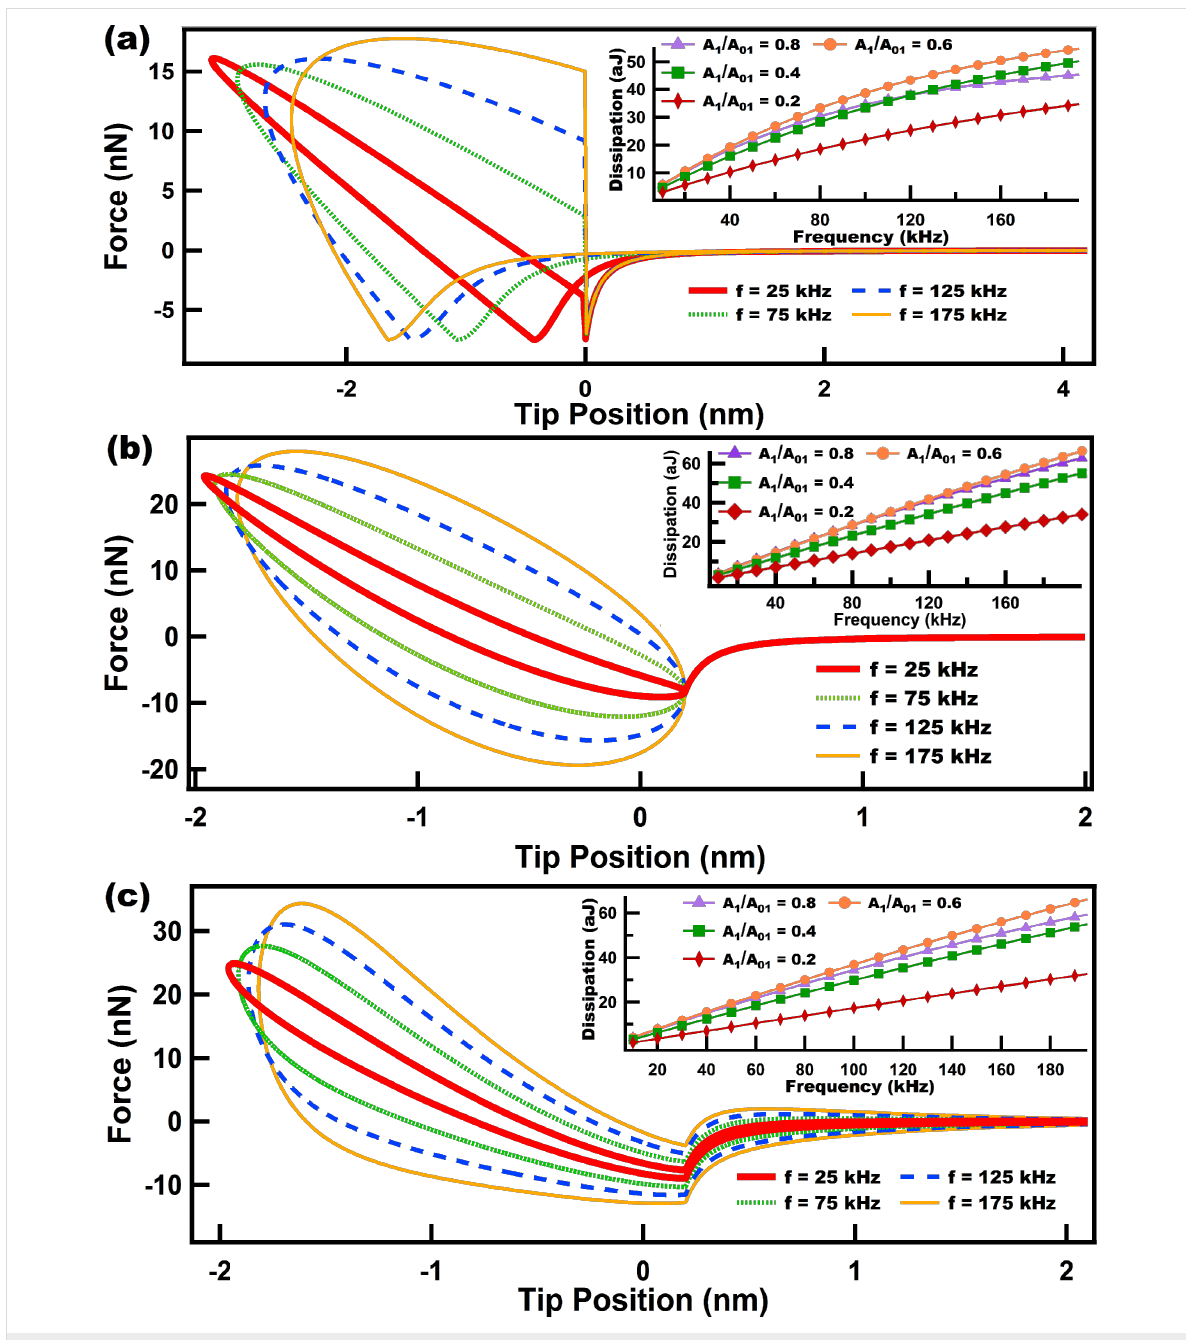
Figure 6: (a), (b) and (c) show force trajectories for a tip following a numerically simulated (not prescribed) single tapping mode trajectory over a Linear Kelvin–Voigt, a DMT-García, and a DMT-Gotsmann sample, respectively. Each of the force trajectories is color-coded according to the cantilever eigenfrequency used in the simulation. The insets in the figures show the behavior of dissipation as the frequency increases, and each color coded line relates to a specific amplitude setpoint ( A 1 / A 01 ). The simulation parameters for the cantilever dynamics in (a), (b) and (c) are: cantilever position z c = 80 nm, free amplitude ( A 01 ) = 100 nm, cantilever stiffness ( k m1 ) = 4 N/m. The Linear Kelvin–Voigt parameters for (a) were k = 7.5 N/m and c = 1.0 × 10 − 6 N·s/m. The sample parameters for (b) and (c) are the same as for Figure 4.